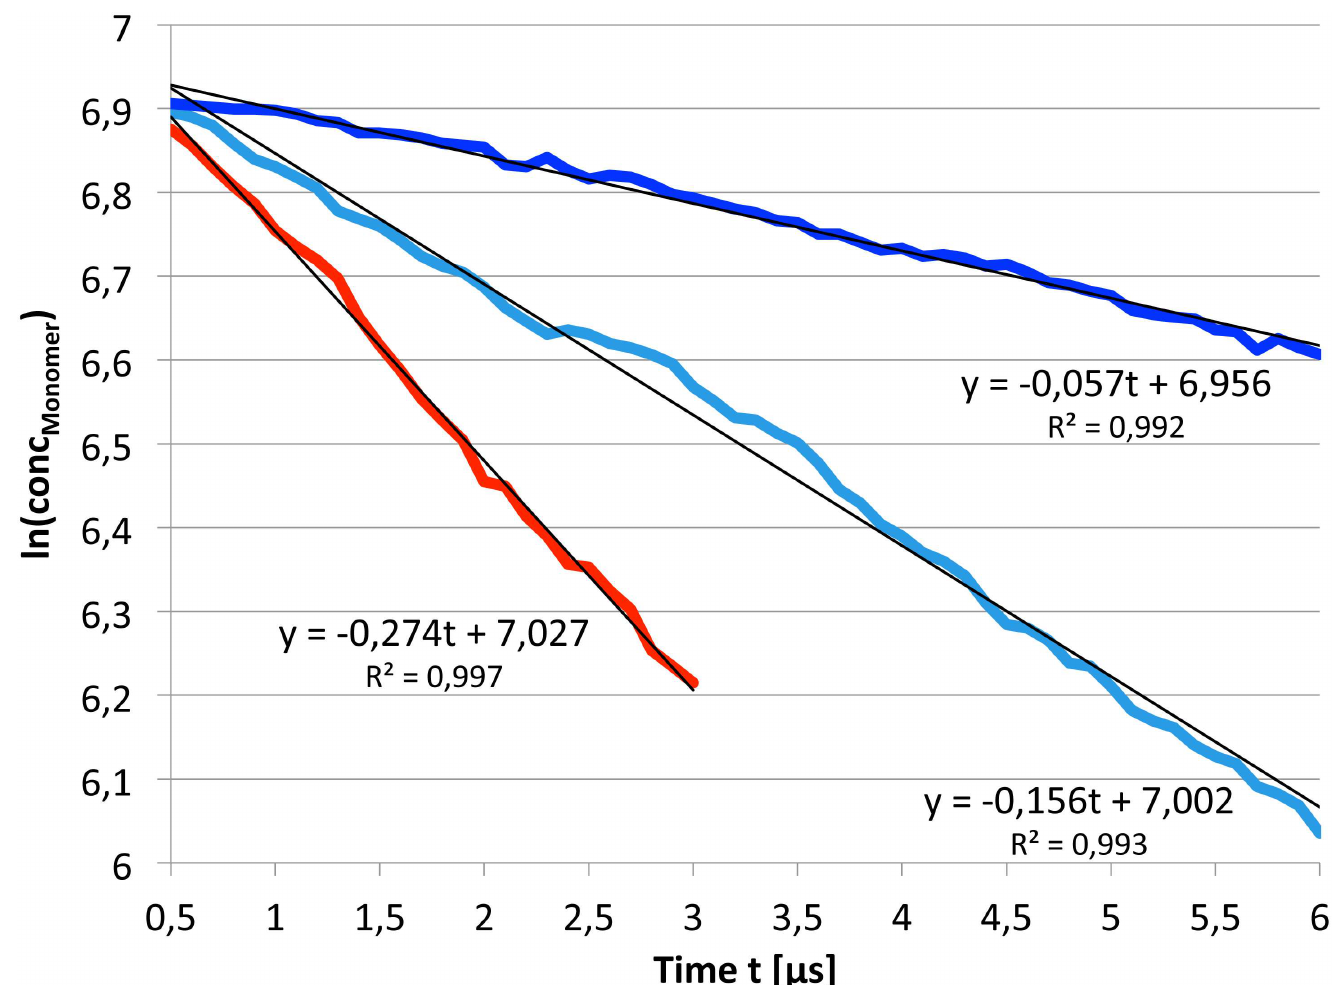
Fig 6. Concentration of receptor monomers as a function of simulation time. The first 500 ns were discardedfor equilibrationpurposes.